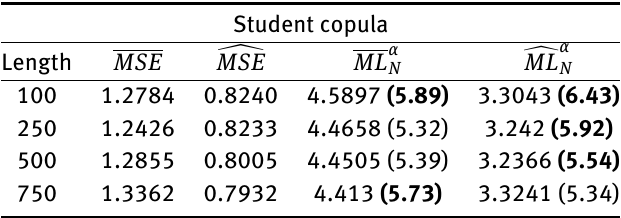
Table 2: Impact of estimation errors for the Student copula. From left to right we have: the length of the series, the mean squared error for the univariate and bivariate methods, and the mean length of prediction intervals for the univariate and bi- variate methods. The numbers in parenthesis are the percentage of observed values out of the prediction intervals. They are written in bold when significantly different from 5%, at the 95%